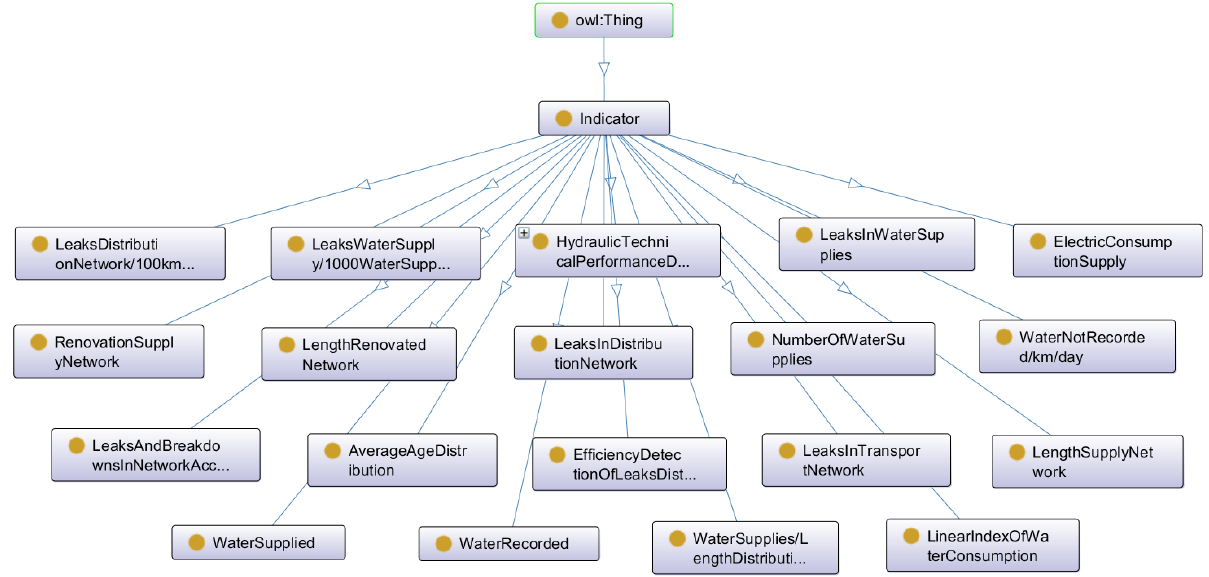
Figure 3. Water Ontology: Subclasses of